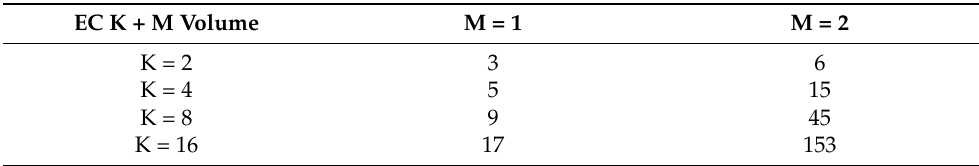
Figure 17. Case where matrices differ in a single fault. Table 3. Number of matrices required for decoding according to EC attributes.